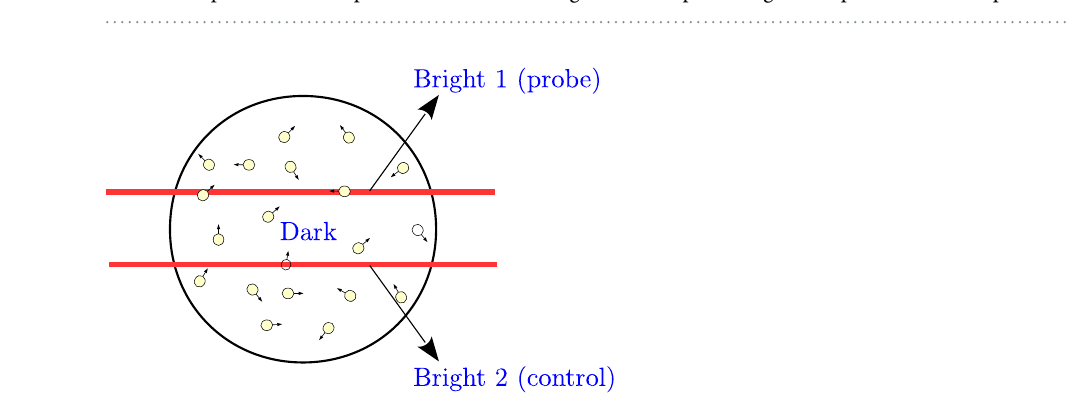
Figure 1. Schematic of the experiment. Figure key: λ /2–half-wave retardation plate; λ /4–quarter-wave retardation plate; PM fiber–polarization-maintaining fiber, PBS–polarizing beam splitter cube; PD–photodiode.